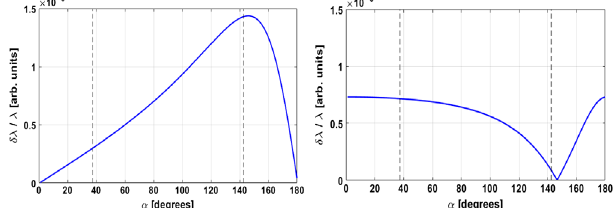
FIG. 2. Deviation of the laser light wavelength in the ion beam reference frame due to 1 mrad deviation of the crossing angles (left) and 1 × 10 − 3 deviation of the ion energy (right) versus the crossing angle.